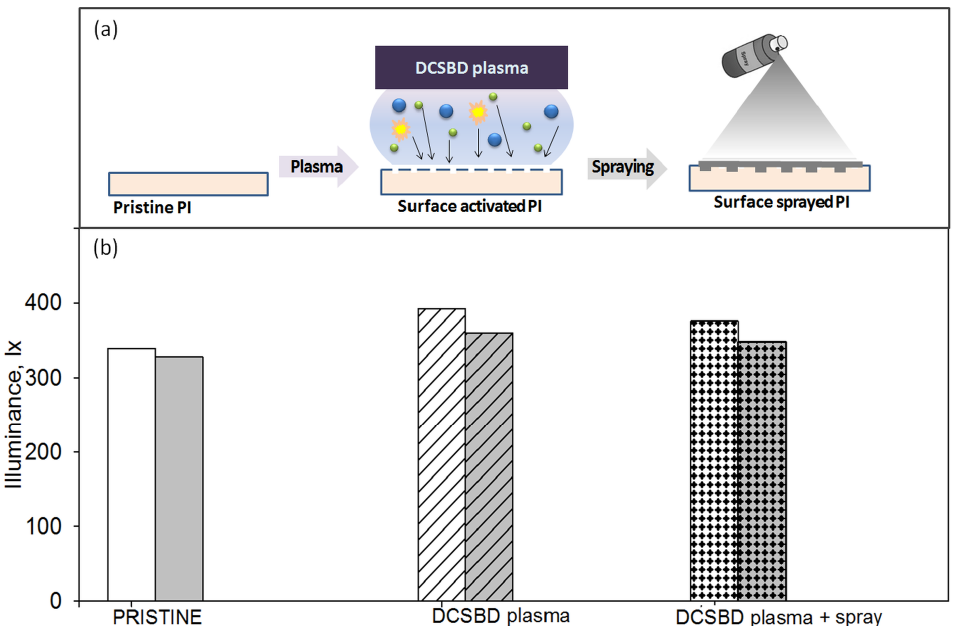
Figure 6. ( a ) The schematic representation of the polymer surface modification approach and ( b ) its influence on the illuminance for the PI-1 and PI-4 samples.